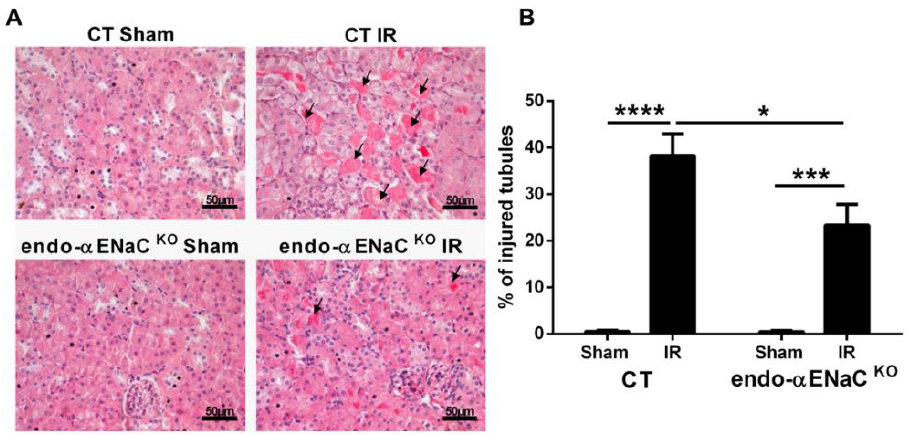
Figure 2. Endothelial αENaC deficiency reduces the tubular injury induced by IR . (A ) Representative images from hematoxylin and eosin stained slides for the sham and IR groups in the control (CT) and mice with αENaC deficiency in the endothelial cells (endo- αENaC KO ) after 24 h of reperfusion. The arrows indicate examples of injured tubules. ( B ) Quantification of the percentage of injured tubules presenting tubular casts, cell detachment, and/or tubular dilation. n = 8 per group. * p < 0.05, *** p < 0.001, and **** p < 0.0001.